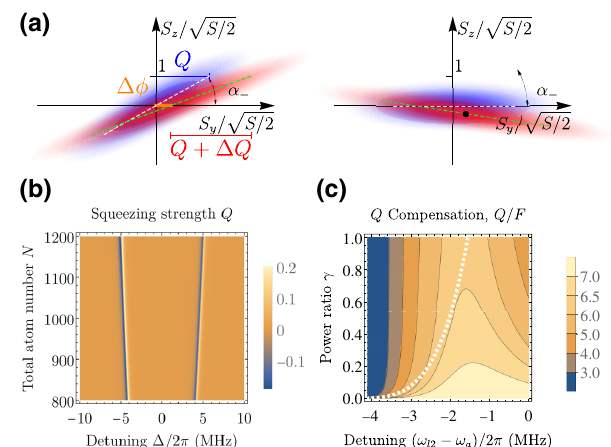
FIG. 11. (a) The quasiprobability for a squeezed state with and without final rotation for the ideal case (blue) and a situation with Q and (cid:7)φ fluctuations (red). (b) Contour plot of the squeezing strength Q per incoming photon as a function of the detuning (cid:7) and total atom number N . In the calculation we use a four- level model with a cavity frequency 2 π × 340 kHz lower than the atomic frequency. (c) Contour plot for the Q / F ratio by fix- ing the detuning of the first squeezing pulse to be 7.333 MHz, and varying the detuning and power ratio of the second pulse. The white dashed line indicates the optimum parameters for auto- matic compensation against atom number fluctuations. The max ratio is Q / F = 6.47 with power ratio γ = 0.52 and red pulse detuning − 2